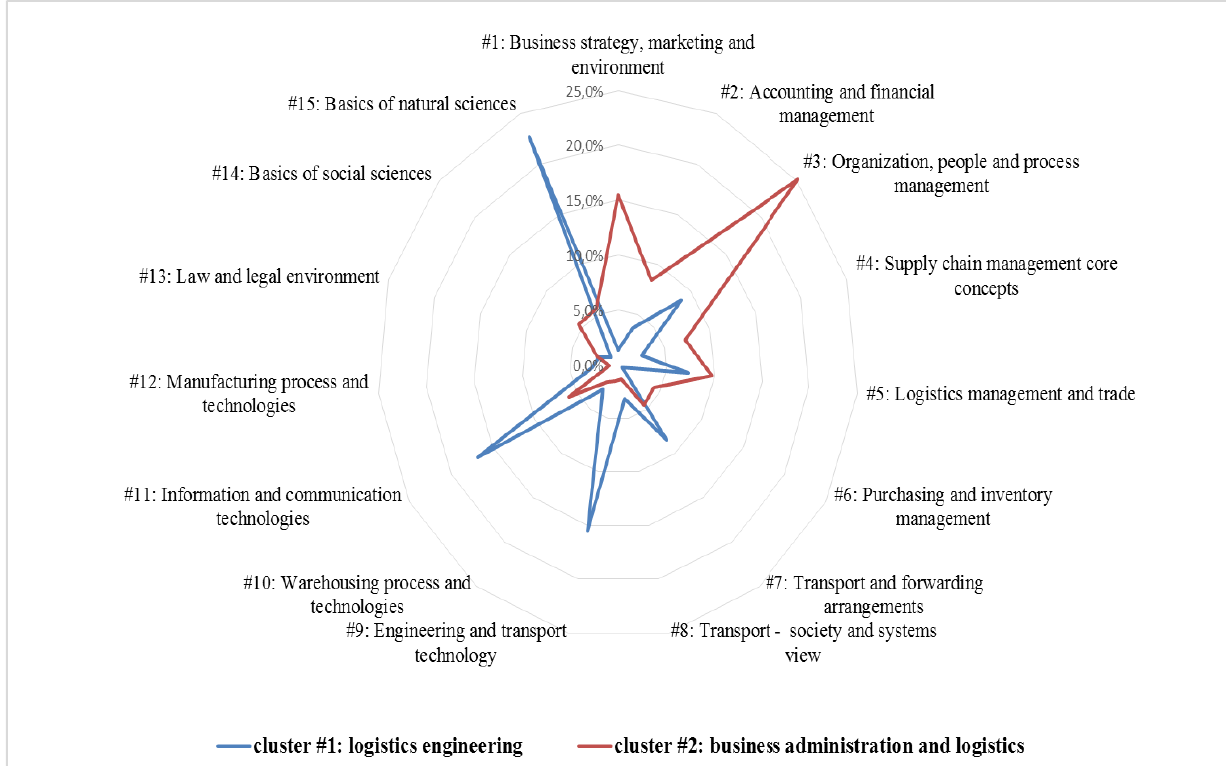
Figure 3. The contrasted curricula profiles in logistics education: logistics engineering and business administration view Source: Authors’